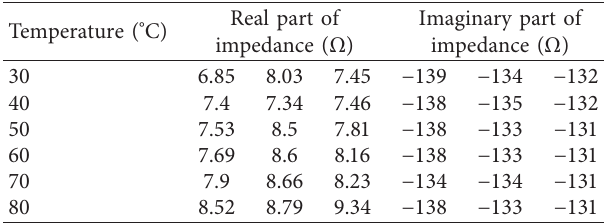
Table 2: Input impedance of the three RFID chips as function of temperature